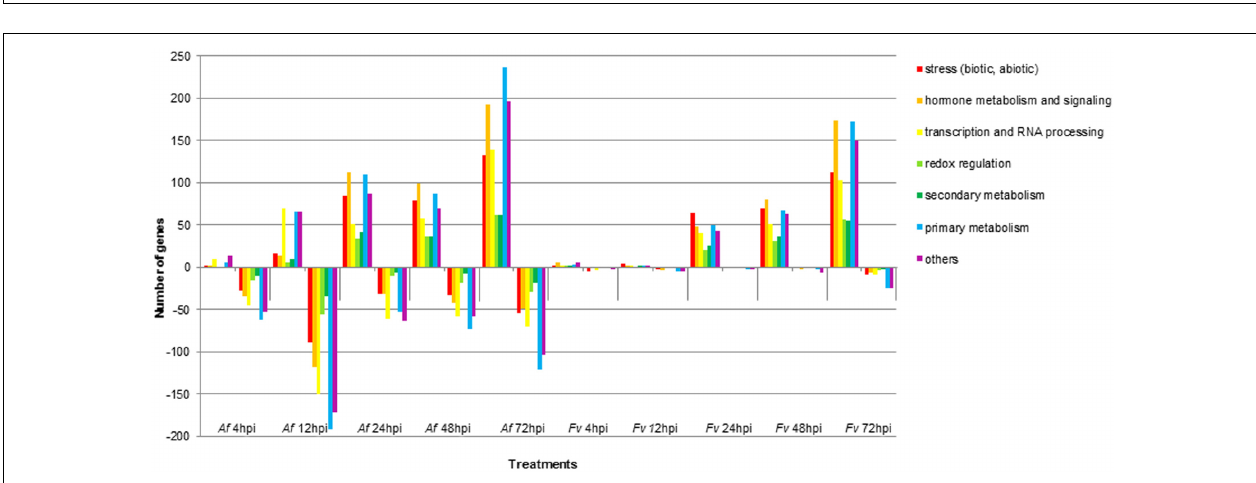
FIGURE 2 | Dynamic changes of kernel transcriptome during A. flavus ( Af ) and F. verticillioides ( Fv ) infection. (A–E) Show total numbers of maize genes differentially expressed in response to A. flavus and F. verticillioides infection at 4 (A) , 12 (B) , 24 (C) , 48 (D) , and 72 (E) hours post inoculation (hpi). Total numbers of up ( ↑ ) and down ( ↓ )-regulated genes of treatment-specific and shared between treatments are displayed in Venn diagrams.